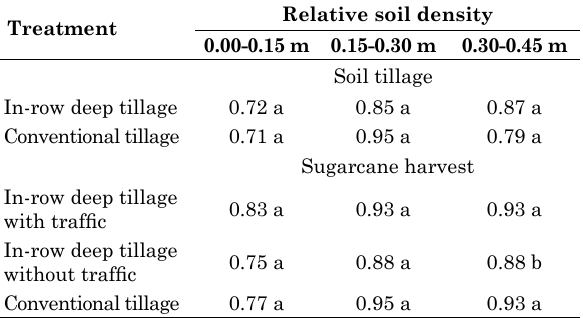
For soil tillage: mean with same letters in a column do not differ by the Tukey test (p<0.10). Standard deviation: 0.13; Coefficient of variation: 31 %. For sugarcane harvest: means with same letters in a column do not differ by the Tukey test (p<0.10). Standard deviation: 0.07; Coefficient of variation: 8